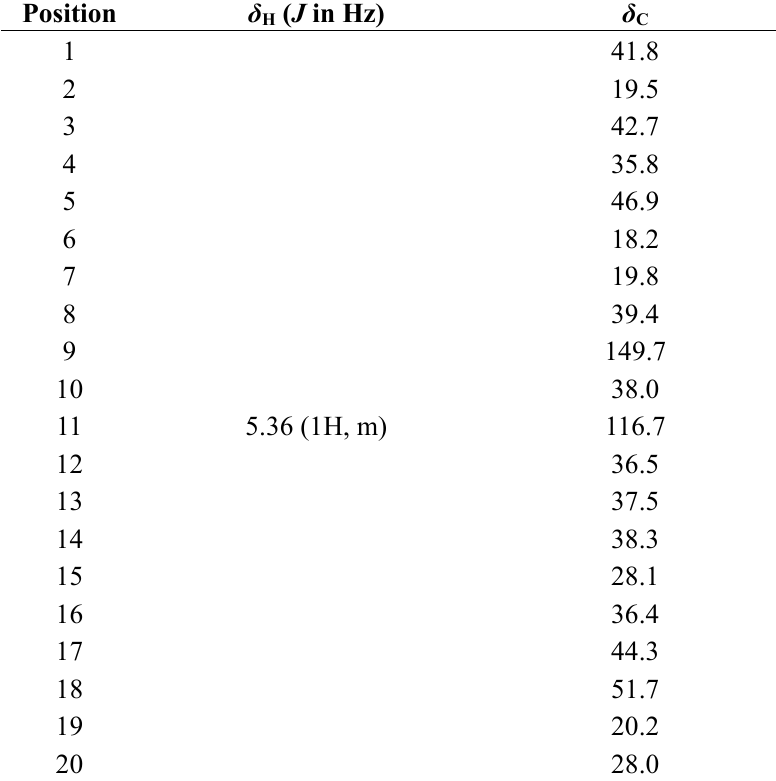
Table 1. 1 H and 13 C-NMR spectroscopic data for davallic